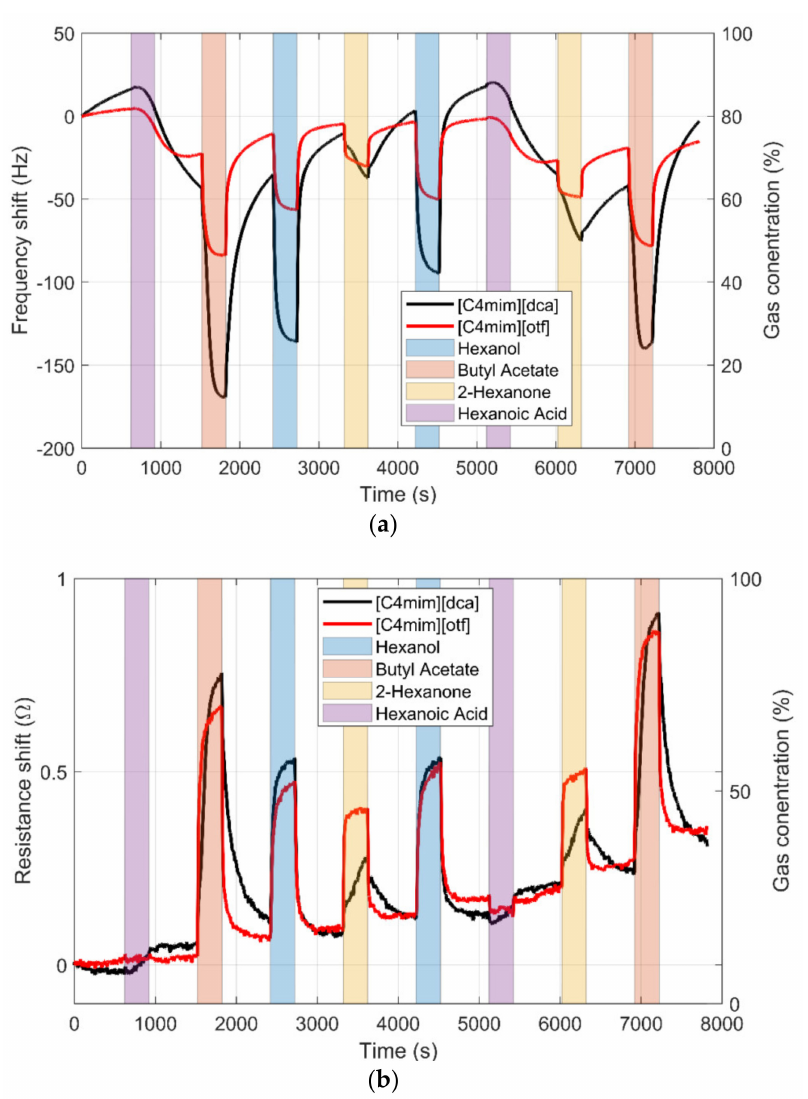
Figure 1. ( a )Typical response of the sensors [C4mim][dca] and [C4mim][otf]. ( b ) Frequency response to the four VOCs. Resistance response to the four VOSs at maximum